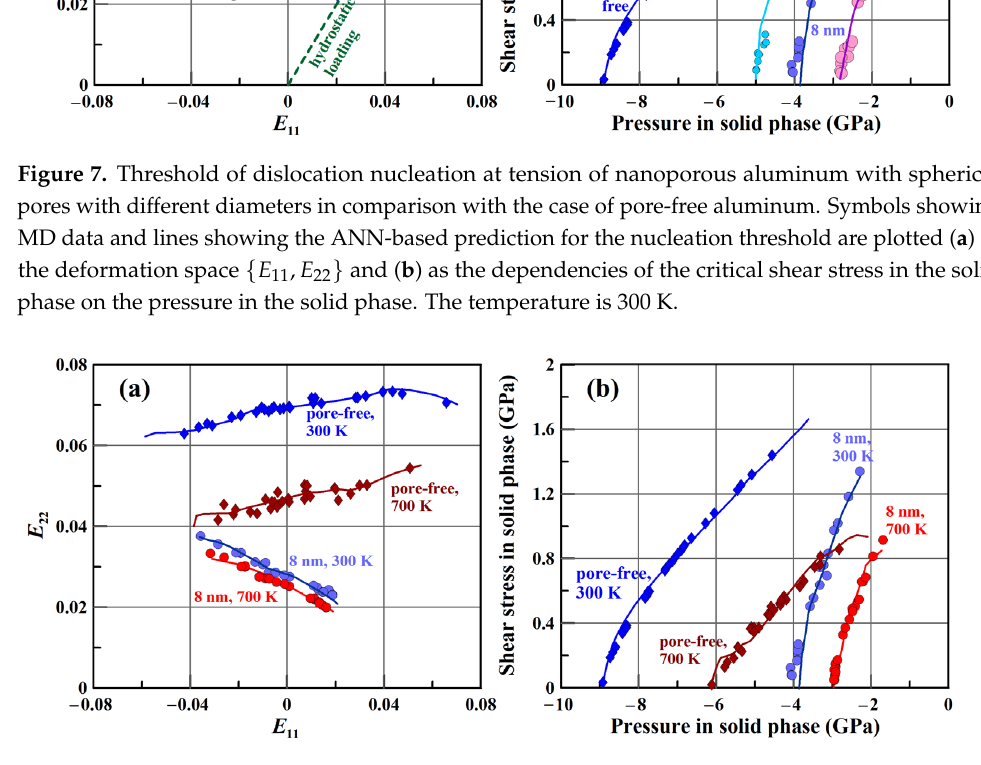
Figure 9. Influence of pore shape on the dislocation nucleation in nanoporous aluminum. Symbols showing MD data and lines showing the ANN-based prediction for the nucleation threshold are plotted ( a ) in the deformation space { 𝐸𝐸 11 , 𝐸𝐸 22 } and ( b ) as the dependencies of the critical shear stress in the solid phase on the pressure in the solid phase. The temperature is 300 K; the equivalent pore size is 8 nm. Data for the case of 8 nm spherical pores in a large MD system of 100 × 100 × 100 lattice parameters (about 40 × 40 × 40 nm 3 ) are shown for comparison. 3.2. Verification of Plasticity and Fracture Model and Identification of Parameters The probability distribution in the parameter space is shown in Figure 10; it is pre- sented by cross-sections over pairs of parameters plotted using 40,000 random sets of the model parameters Α = { 𝛾𝛾 , 𝜀𝜀 m , 𝛼𝛼 , 𝑘𝑘 n , 𝑘𝑘 a } . It should be mentioned that these cross-sectional plots accumulate all points along the axes of three other model parameters in one point; therefore, the actual position of the maximum in the five-parameter space can be dis- missed from what appears in these plots. At the same time, Figure 10 provides the basic information about the obtained probability distribution: not a strict maximum, but any set of parameters that are in the area of high probability can be chosen as the optimal one. One can see in Figure 10a that the area of high probability forms a stripe along 𝛾𝛾 , which means that the model results are insensitive to the surface tension for the considered pore sizes. Nevertheless, the maximum probability is located at 1 J/m 2 , and we select this value as shown in Figure 10a and Table 1; this value is not contradictive to a solid metal. The hardening coefficient 𝛼𝛼 in Figure 10b can be also selected in a relatively wide range, from 0.5 to 1, and we select 0.5 as the more common one. In contrast, the dislocation multiplication energy 𝜀𝜀 m and the nucleation barrier 𝑘𝑘 n are well-defined in narrow intervals in Figure 10, which shows the high sensitivity of the model to these parameters. The model provides